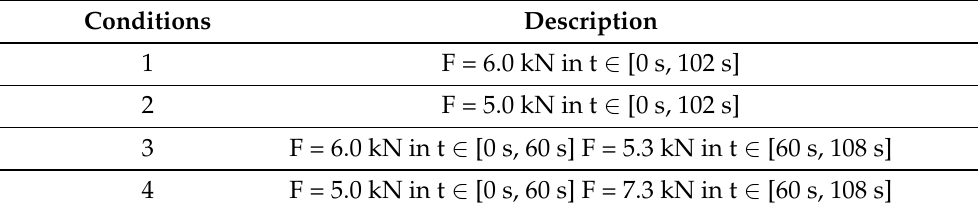
Figure 2. Field layout of the stay cable in the scale model experiment. Table 1. Information of designed conditions in the scale model